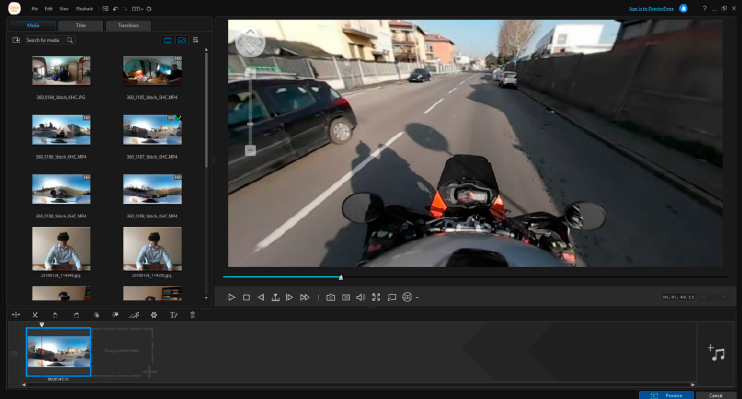
Figure 8. Video editing procedure.